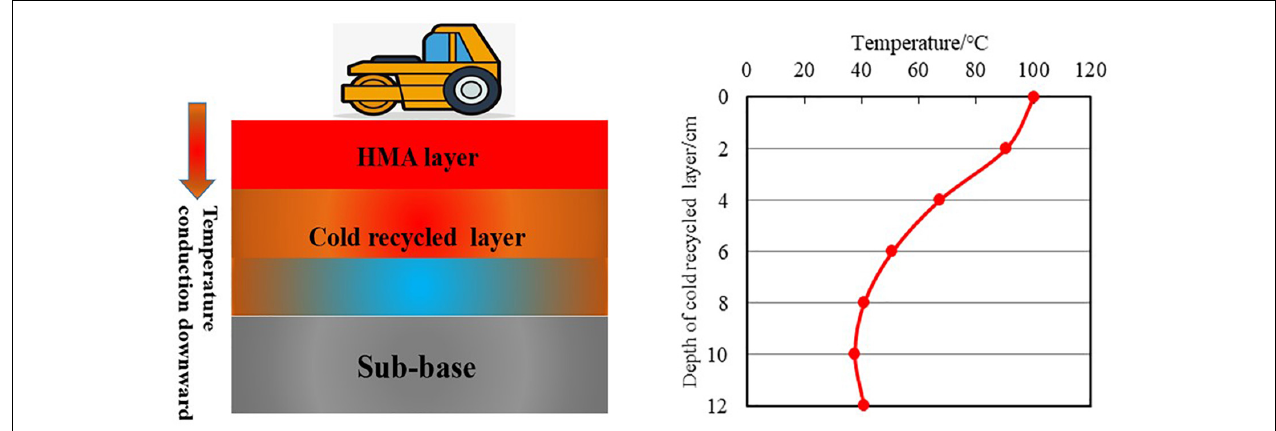
FIGURE 1 | The influence of HMA on the temperature distribution of cold recycled